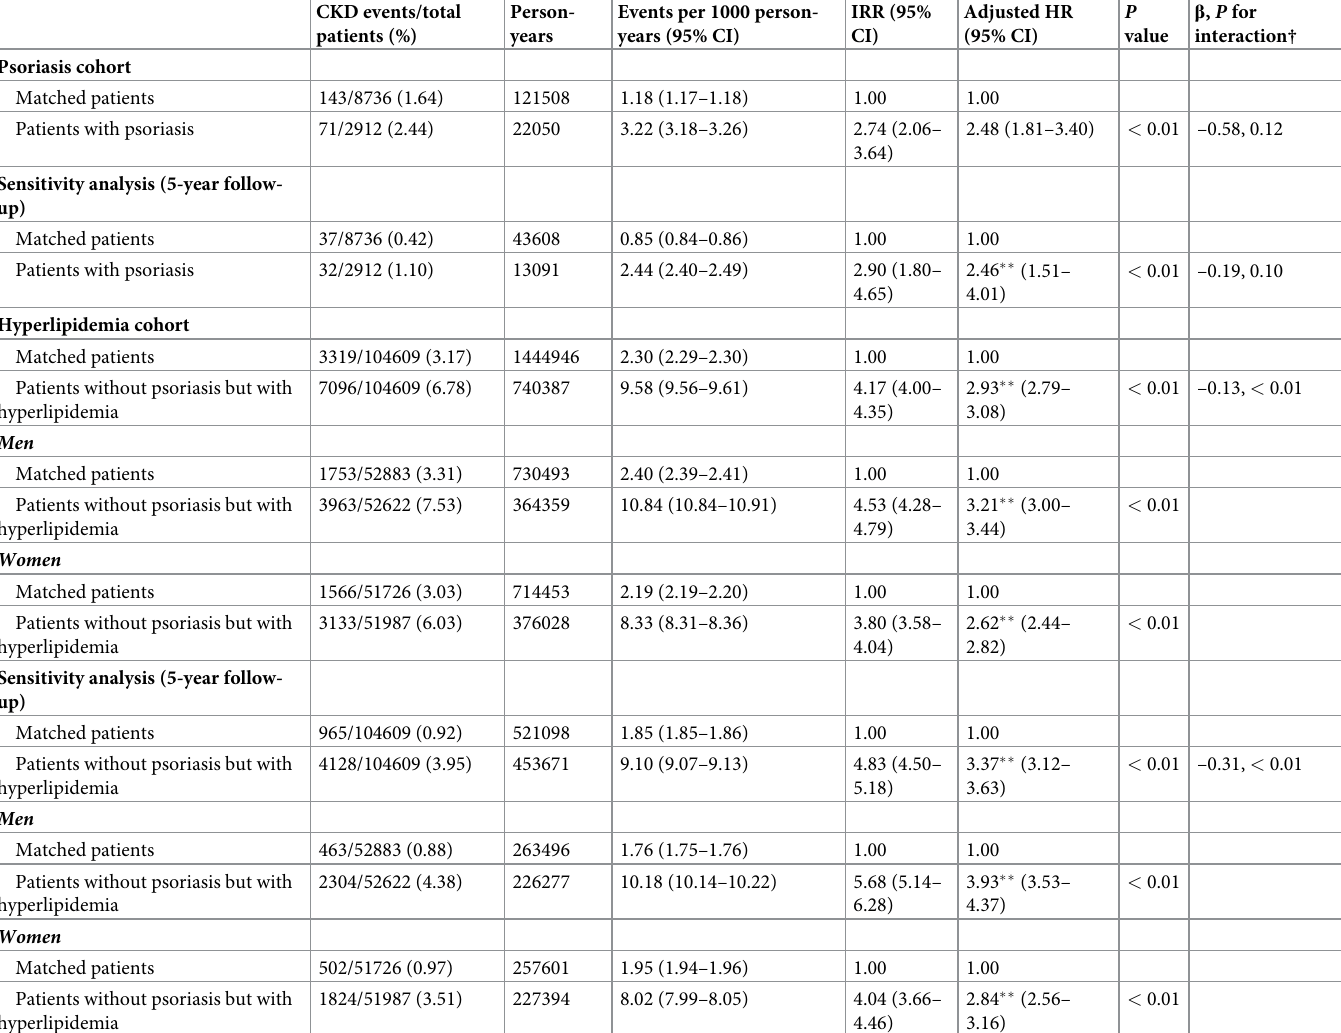
Table 2. Chronic kidney disease events in the psoriasis cohort and the hyperlipidemia